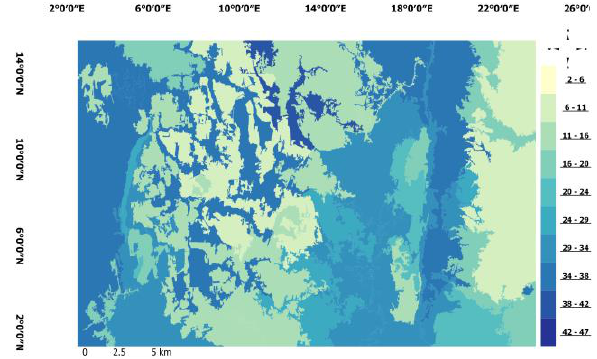
Figure 4. Object-based soil moisture map of the study area with scale parameter 800 and average objects area of 9 km 2 Figure 1. Google earth view of the study area (Uasin Gishu County, Kenya)